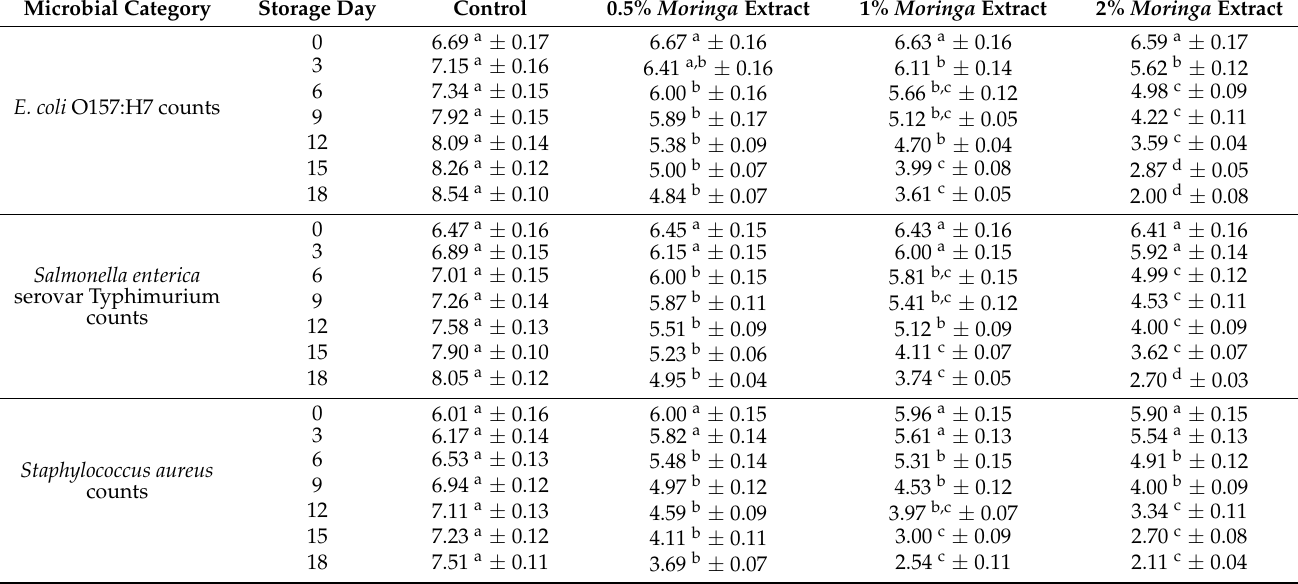
Table 1. Effect of Moringa oleifera leaves extract supplemented to ground beef on artificially inoculated E. coli O157:H7, S. enterica serovar Typhimurium, and S. aureus counts (log 10 CFU/g) during cold storage at 4 ◦ C for 18